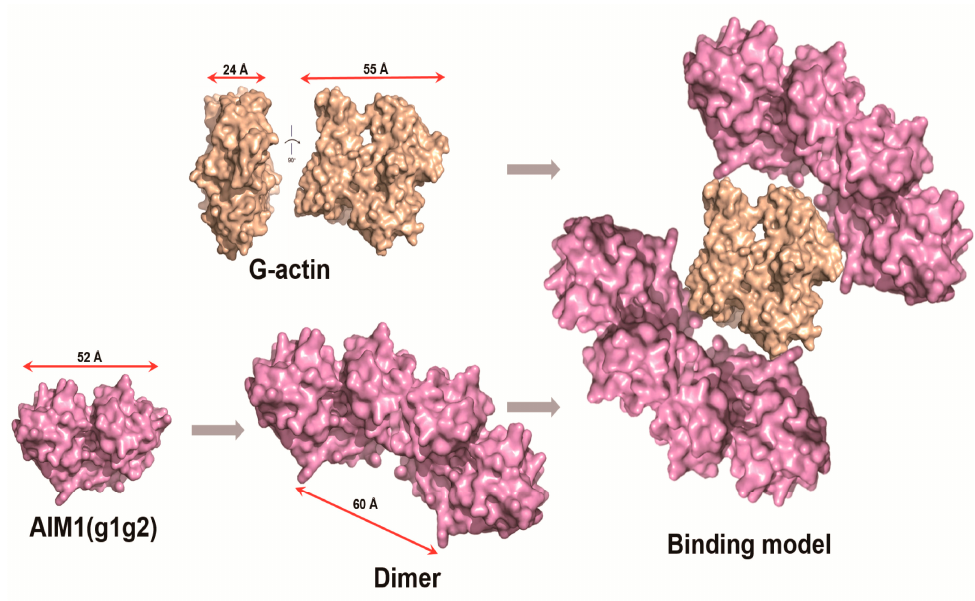
Figure 5. Structural model of g1g2 interacting with G-actin. The wheat color indicates G-actin. The magenta color represents g1g2. To obtain the structural model of the g1g2, we put the atomic structure of g1 from PDB (PDB ID: 3CW3) and the amino acid sequence of g1g2 into the website (www.sbg.bio.ic.ac.uk/phyre2page). The atomic structure of G-actin was got from PDB (PDB ID: 3HBT). The three-dimensional structure of g1g2 was predicted and the picture was prepared using PyMOL.